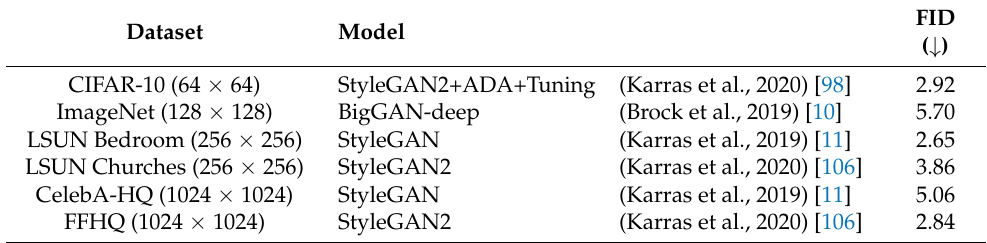
Table 16. The model that achieved the highest FID performance in each dataset. The lower the FID value, the better the